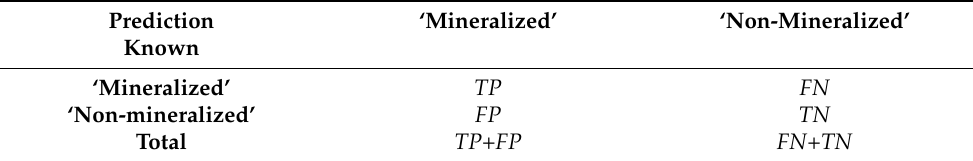
Table 1. Confusion matrix.